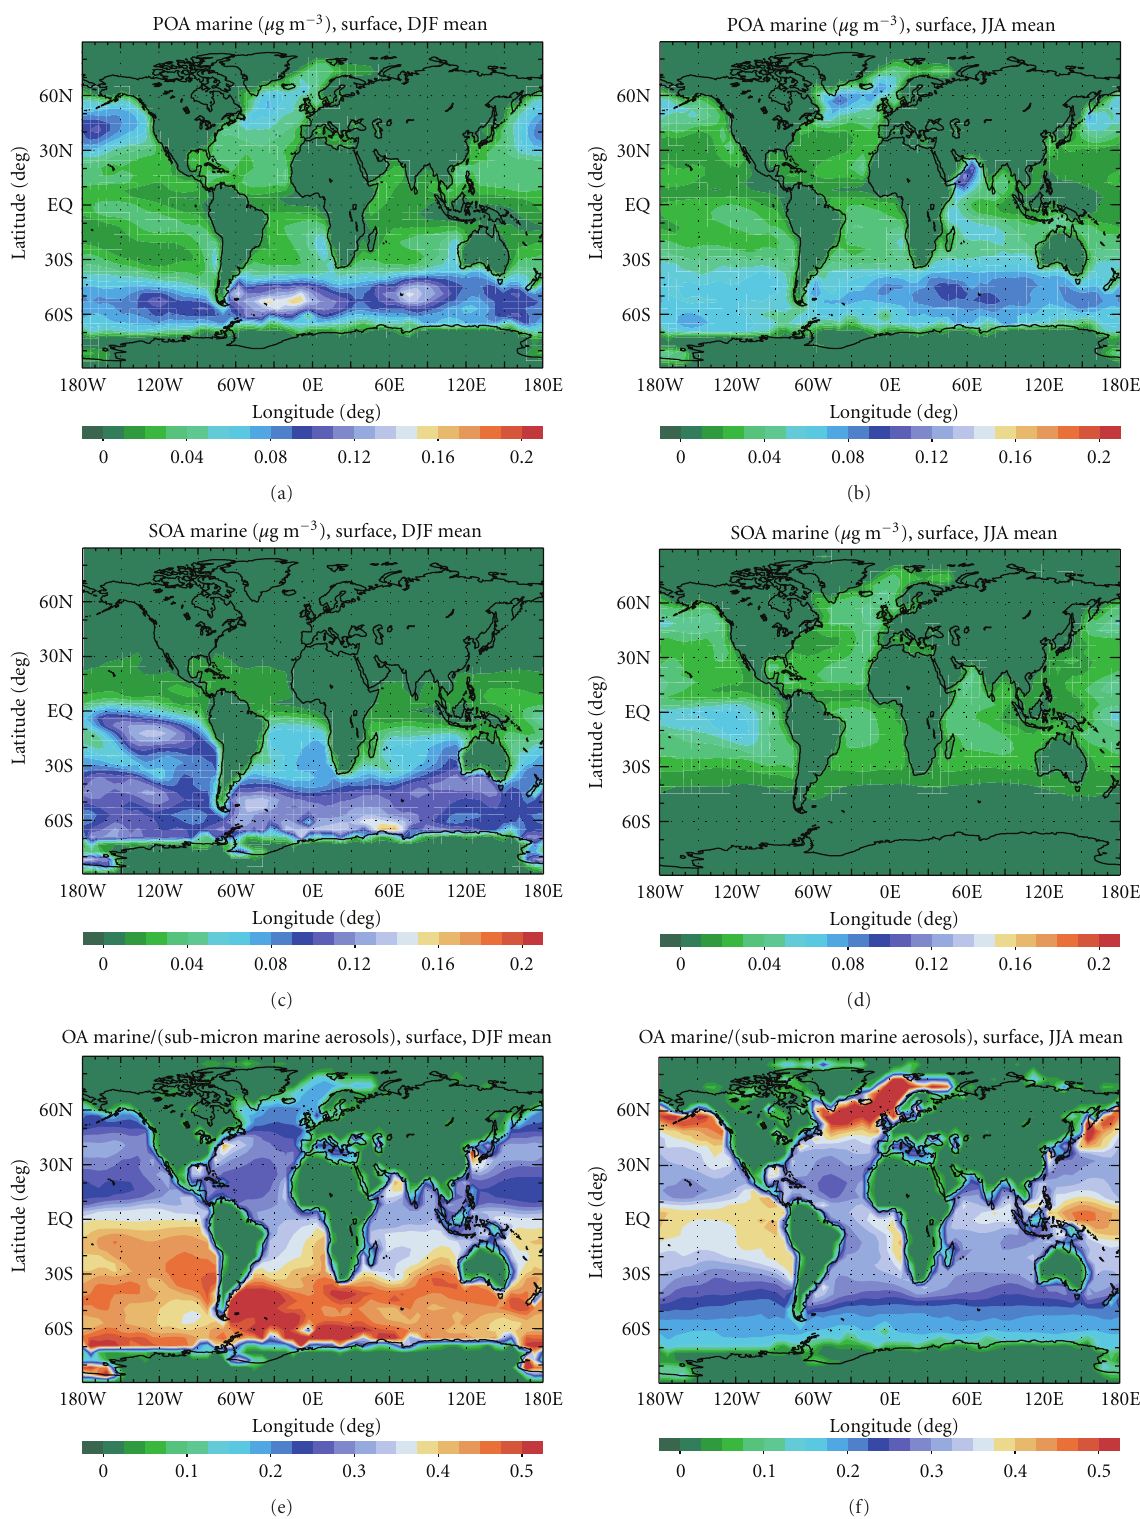
Figure 3: Calculated mean surface distributions for S1 of ((a), (b)) marine submicron POA ((c), (d)) marine SOA in μ g m − 3 ; ((e), (f)) mass ratio of marine OA (POA+SOA) to marine sub micron aerosol (sum of OA, SO 4 = and sea-salt in the accumulation mode) for DJF ((a), (b), and (c)) and JJA ((b), (d), and (f))